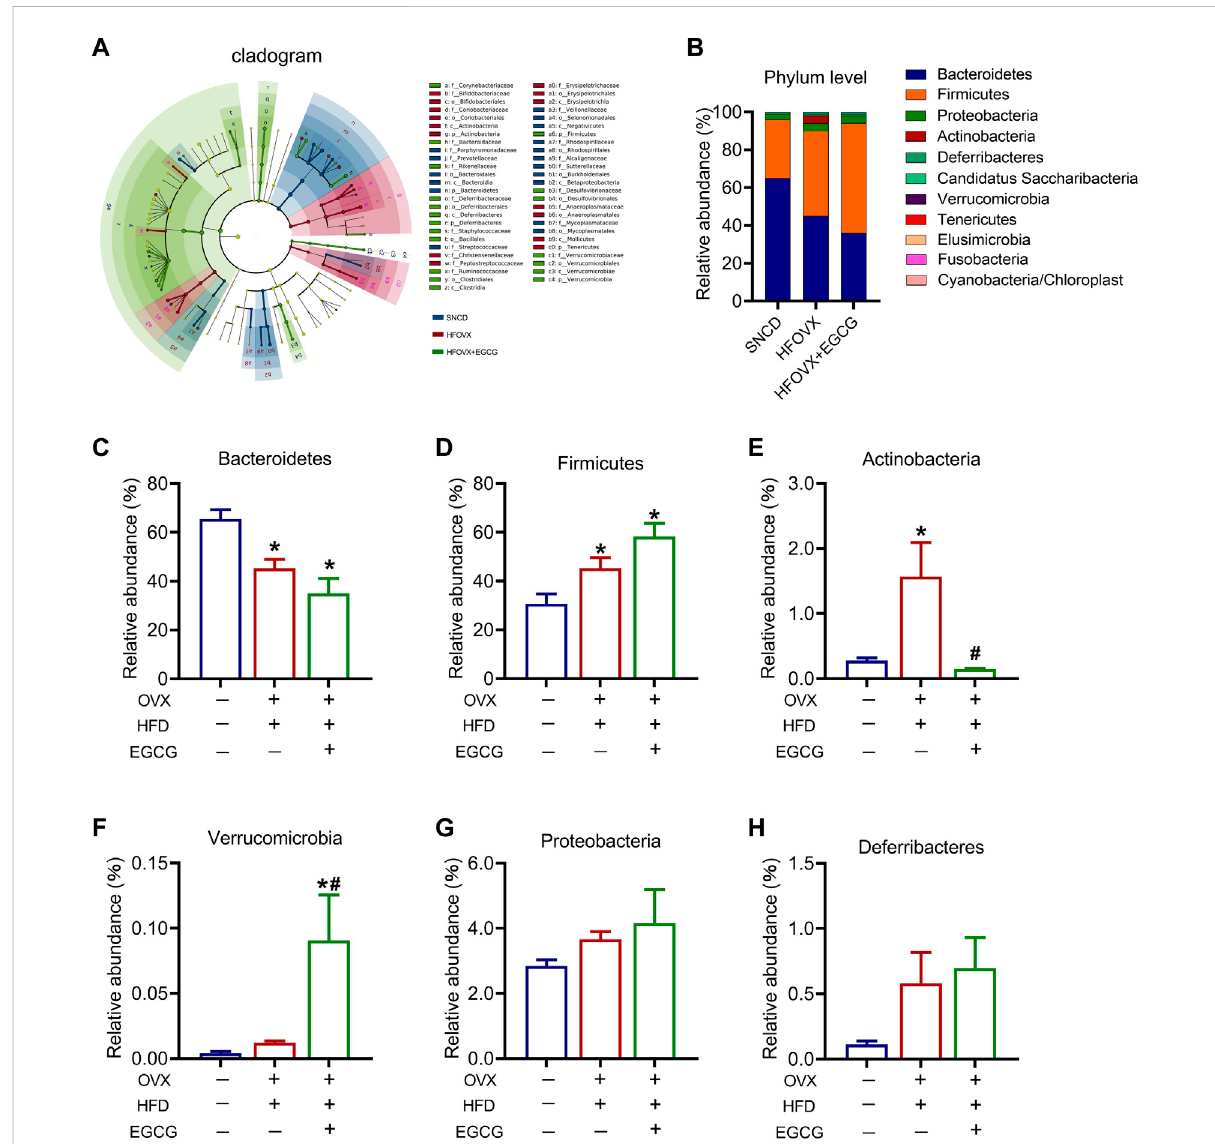
FIGURE 3 In fl uenceofanHFDwithestrogende fi ciencyandEGCGtreatmentongutmicrobiota. (A) Cladogramoflineardiscriminantanalysis(LDA)effect size (LEfSe) method shows the phylogenetic distribution of gut microbiota in the three groups of mice. Blue represents the SNCD group; red represents the HFOVX group; green represents the HFOVX+45 mg/kg EGCG group. (B) Species pro fi ling histogram of the gut microbiota community structure at the phylum level in each group. The abscissa is the group name, and the ordinate is the relative abundance of species. Differentcolorscorrespondtodifferentspeciesnames,andthelengthofthecolorblockindicatestherelativeabundanceofthespeciesrepresented by the color block; n = 7 mice. (C – H) Relative abundance of each group at the phylum level of Bacteroidetes (C) , Firmicutes (D) , Actinobacteria (E) , Verrucomicrobia (F) , Proteobacteria (G), and Deferribacteres (H) . * p < 0.05 HFOVX group vs. SNCD group, or HFOVX + EGCG vs. SNCD group; # p